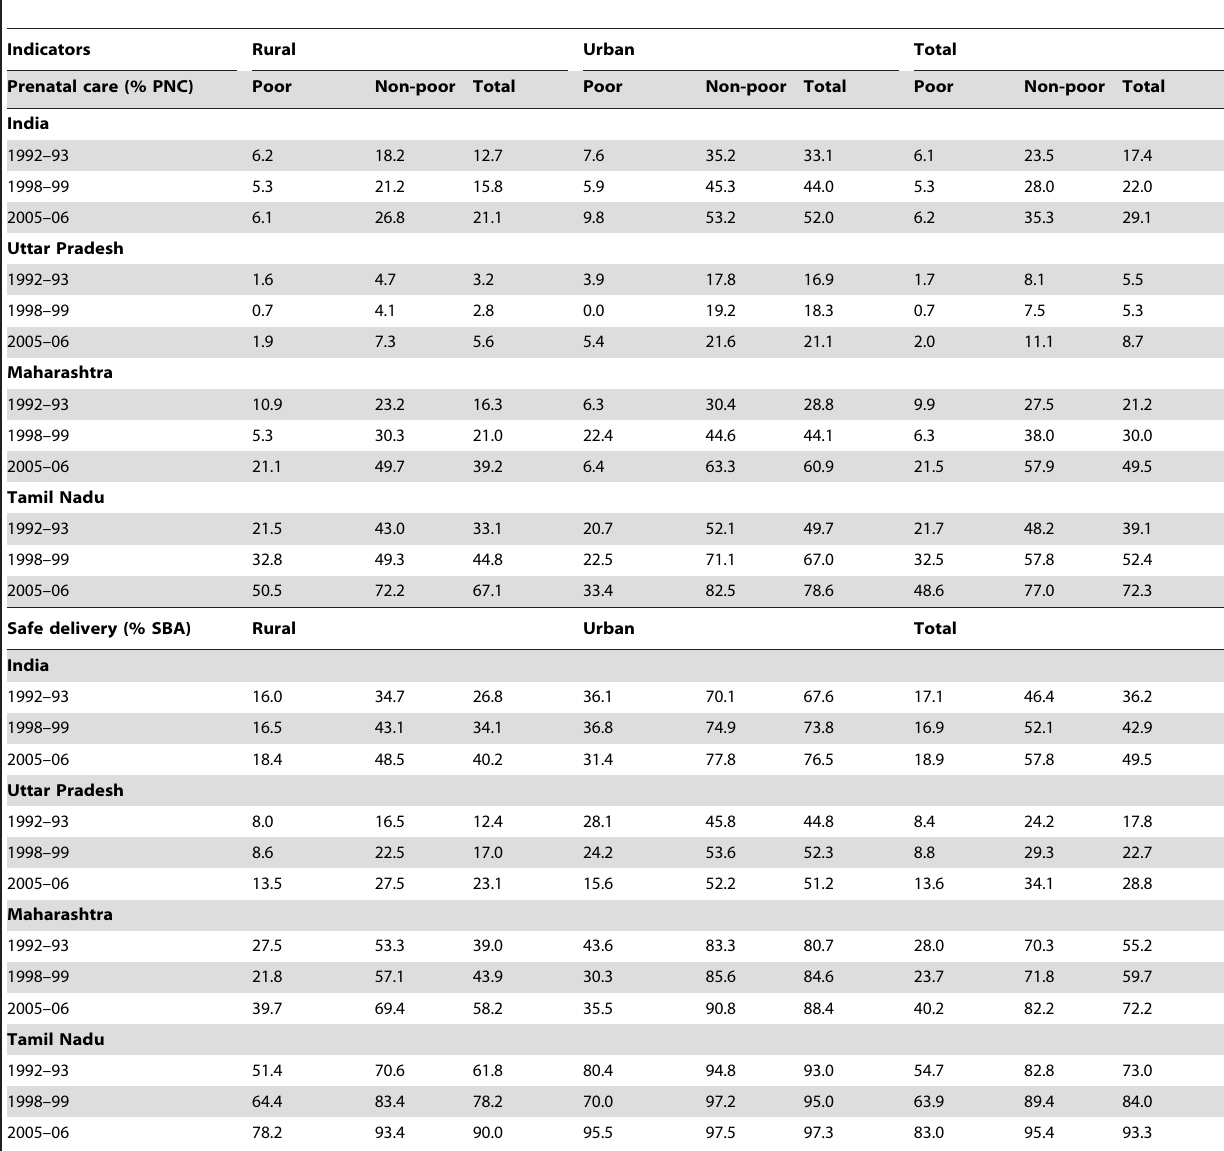
Table 2. Trends in prenatal care and skilled birth attendance (natal care) among poor and non-poor mothers across selected states, India,